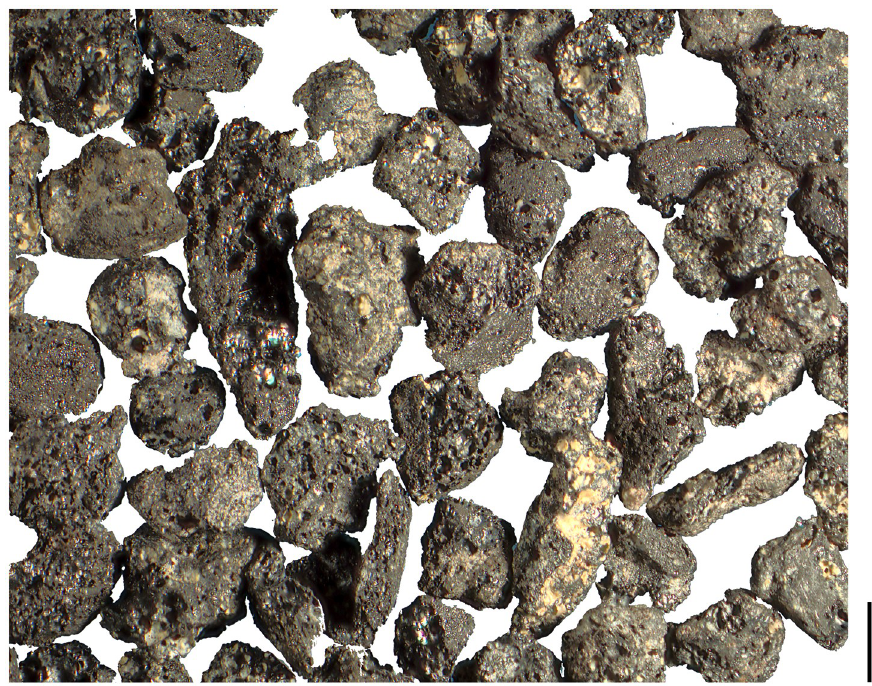
Fig 21. Typical state of preservation of the cereal grain fragments from Prigglitz-Gasteil. Image: OeAW-OeAI/S. Wiesinger.